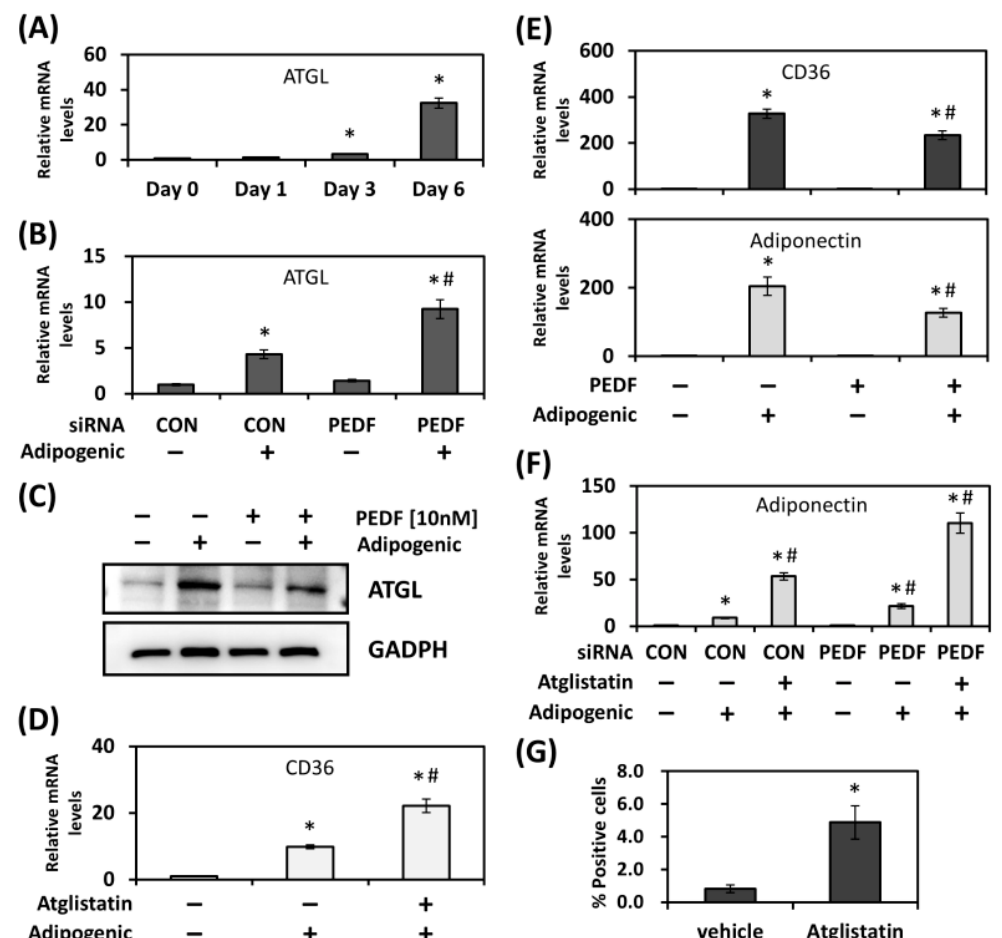
Figure 2. Blockade of ATGL activity promotes adipogenic differentiation. ( A ) ATGL expression was measured in differentiated rat AdSCs using quantitative RT-PCR. ( B ) ATGL expression was evaluated in differentiated rat AdSCs transfected with control or PEDF siRNA ( C ) Mouse 3T3-L1 cells induced for adipogenic differentiation were treated with recombinant PEDF. ATGL protein levels were determined using immunoblotting. ( D ) CD36 expression was measured in differentiated 3T3-L1 cells in the absence or presence of an ATGL inhibitor, Atglistatin. ( E ) Effects of PEDF on CD36 and adiponectin expression were determined in differentiated 3T3-L1 cells. ( F ) Adiponectin expression was evaluated in differentiated 3T3-L1 cells transfected with control or PEDF siRNA, in the absence or presence of Atglistatin. ( G ) As in ( D ), differentiated 3T3-L1 cells were stained with BODIPY 493/503 and counterstained with DAPI. Percent positive cells were determined by calculating the percentage of positively stained cells in all DAPI-stained cells. * Statistically significant compared with the control transfected, vehicle-treated group at p < 0.05; # statistically significant compared with the PEDF siRNA/PEDF protein-treated, vehicle-treated group at p < 0.05.